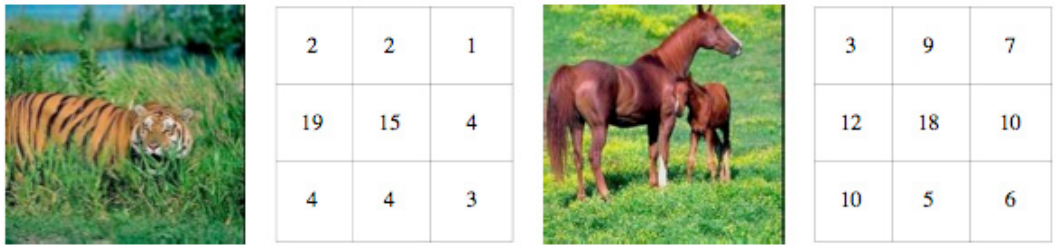
Figure 7. Sample region codebook sizes.